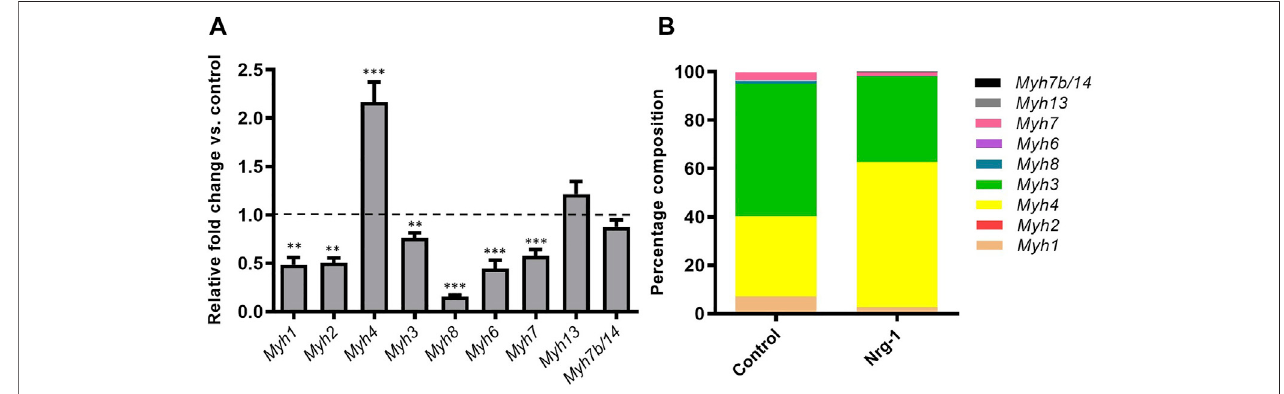
FIGURE4| Nrg-1treatmentledtosigni fi cantchangesinMyhexpressioninallbuttwoisoforms. (A) RT-qPCRanalysisofalldetectableMyhisoformsfollowingNrg- 1treatmentvscontrol.Controlvaluesarenotshown andarerepresentedbythedotted lineat 1.0. (B) Proportionalrepresentation forMyhexpression.Mean ± SEM, n (cid:1) 9, ** p < 0.01, *** p <